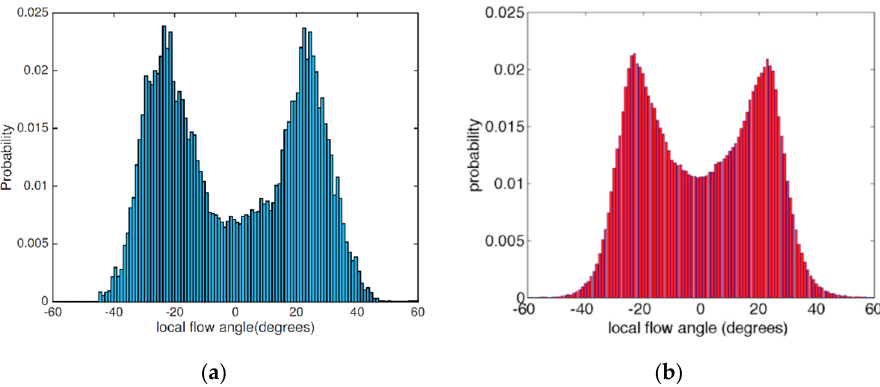
Figure 15. Local flow angle distribution in cylinder wake. ( a ) Simulation, ( b ) Experiment.